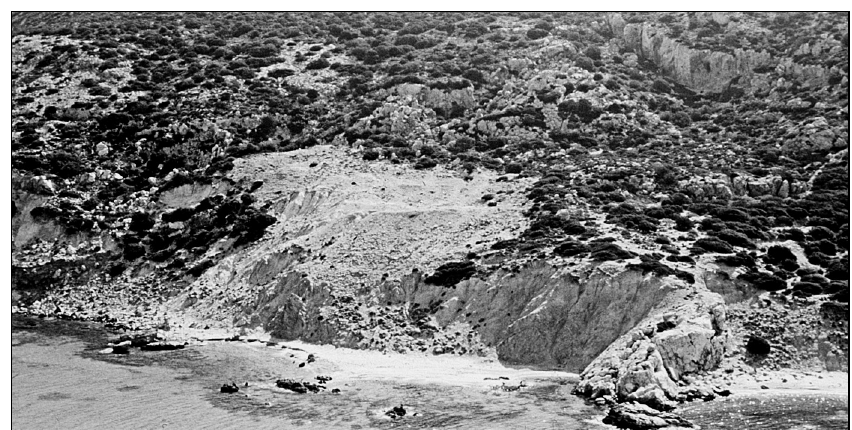
Figure 6 A view of the northern part of the site of Dhaskaleio Kavos on Keros, showing the devastation of the site brought about by looting for the antiquities